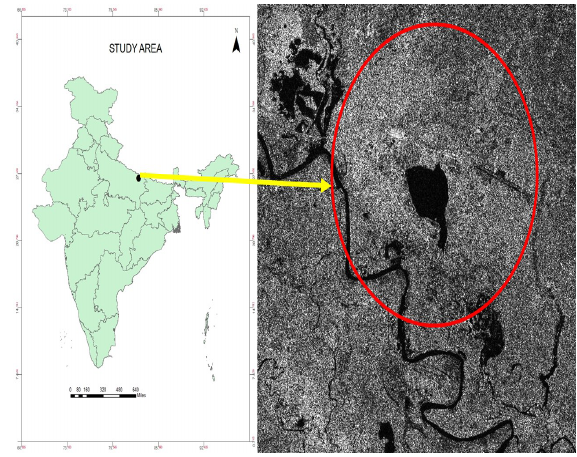
Figure.1. Study area (The dot shows the location of Gorakhpur) with pre-processed SAR image .